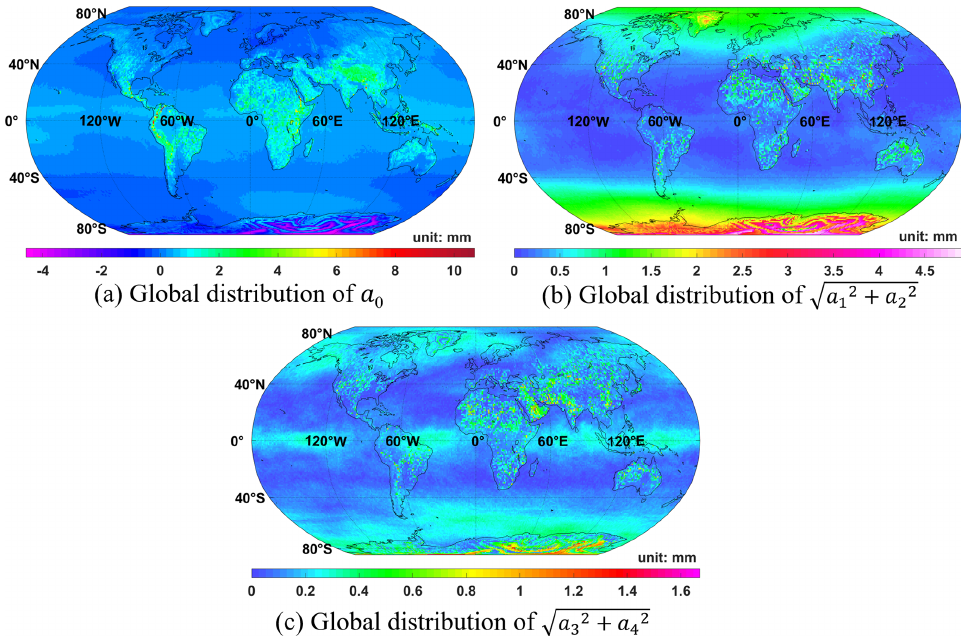
Figure 7. Global distribution of coefficients as a periodic function. Changes in the constant term and annual and semi-annual amplitudes are described in (a) – (c) , respectively.